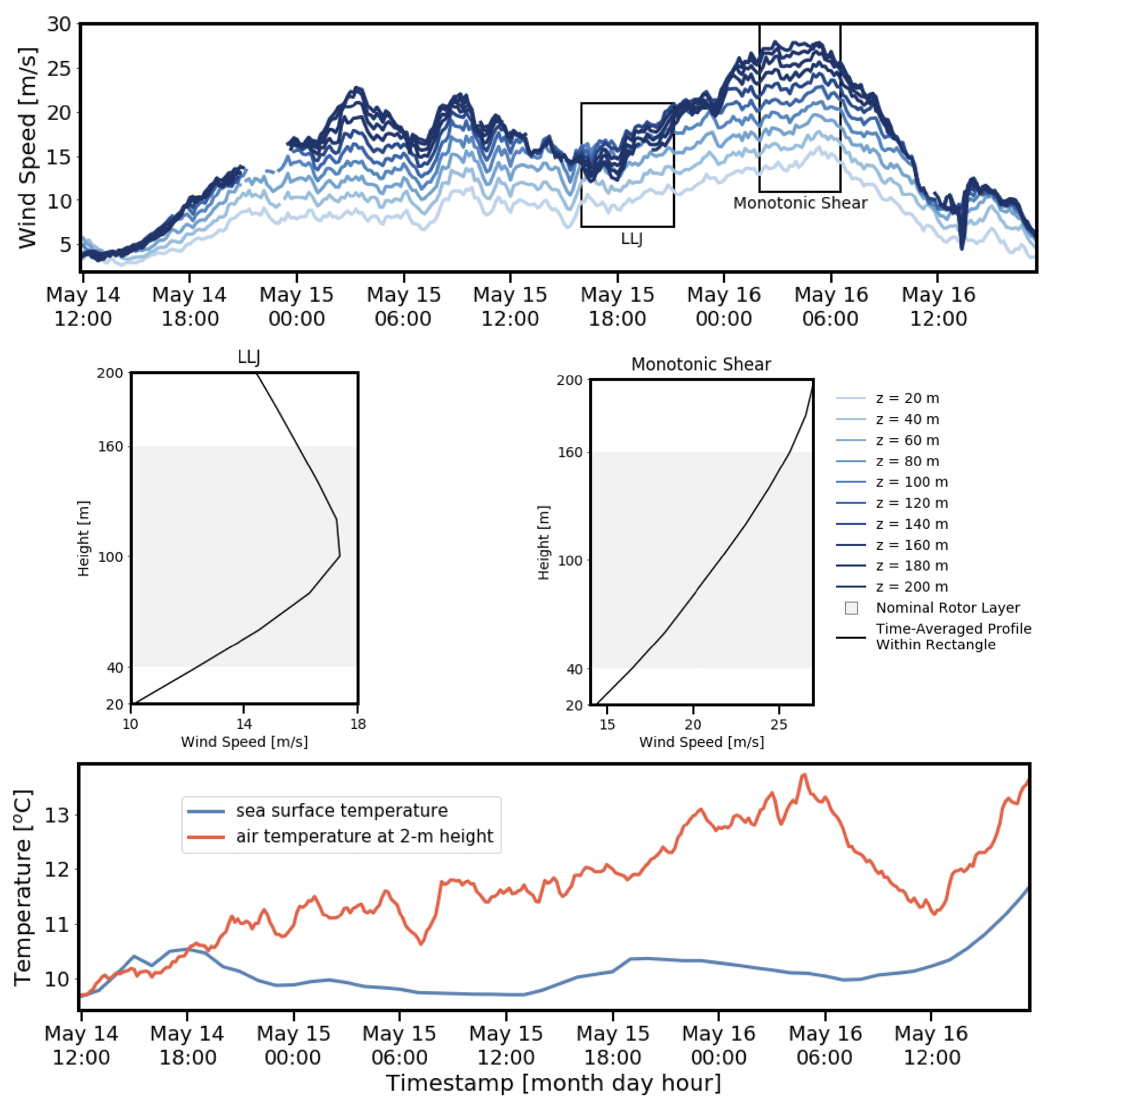
Figure 5. A high-shear wind event measured by a floating lidar deployed within the wind lease areas of the New Jersey coast (top). The middle figure provides the time-averaged wind speed profiles of the black boxes shown in the top figure. The SST and air temperature at 2m height measured at the same location are provided in the bottom figure (from Debnath et al.,